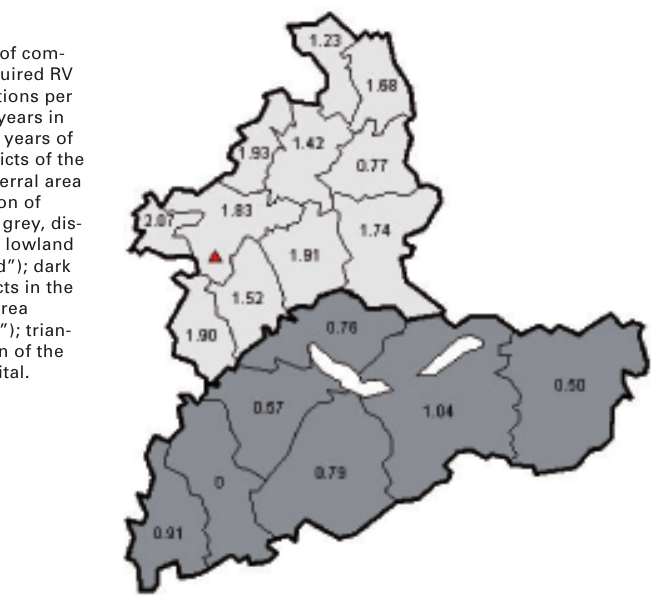
Figure 3 Incidences of com- munity-acquired RV hospitalisations per 1000 child-years in children <5 years of age in districts of the primary referral area in the Canton of Bern. Light grey, dis- tricts in the lowland (“Mittelland”); dark grey, districts in the mountain area (“Oberland”); trian- gle, location of the study